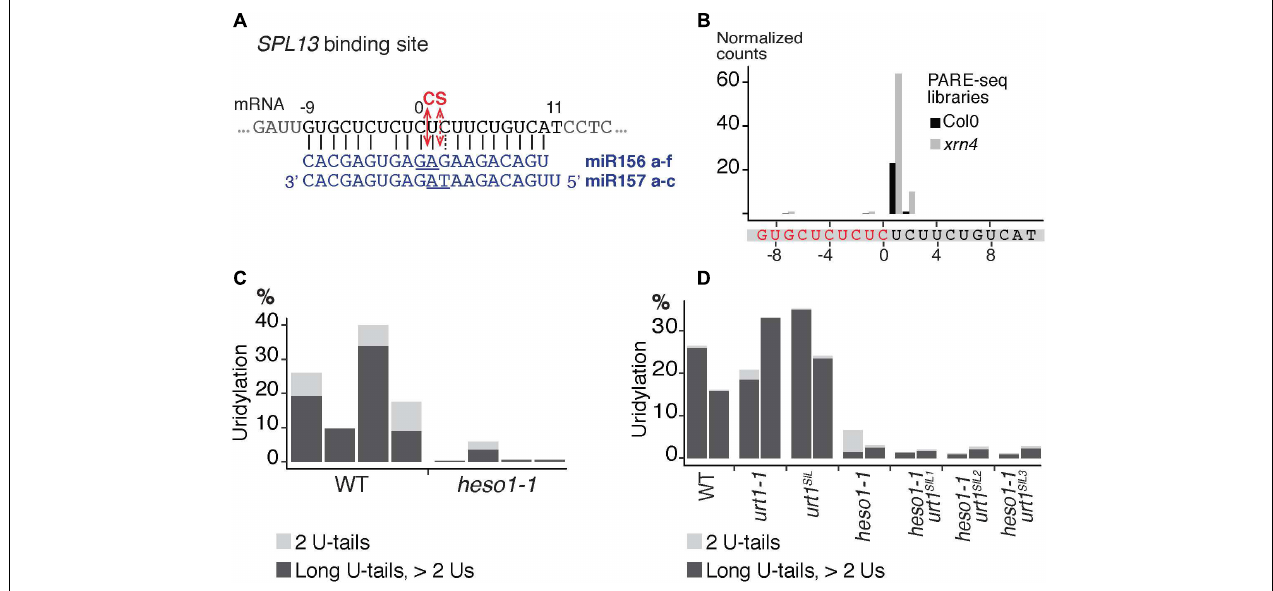
FIGURE 7 | Respective contributions of HESO1 and URT1 in the uridylation of SPL13 RISC 5 (cid:48) -cleavage fragments. (A) Schematic representation of the cleavage of SPL13 mRNA by AGO1 loaded with miR156 or miR157. The cleavage sites (CS) are predicted between the positions 0 and +1 or between position +1 and +2 for miR156 and miR157, respectively, and are defined by the 10th and 11th nucleotides (underlined) of the miRNAs. (B) 5 (cid:48) end mapping using PARE-seq data (German et al., 2008) of RISC 3 (cid:48) -cleavage fragments in WT and xrn4 . (C,D) Percentages of uridylated SPL13 RISC 5 (cid:48) -cleavage fragments in (C) four biological replicates for WT and heso1-1 or (D) two biological replicates for WT, urt1-1 , the urt1 SIL line, heso1-1 , and the three heso1-1 urt1 SIL lines (i.e., six heso1-1 urt1 SIL samples). Percentages of long ( > 2 Us) and 2 U-tails are indicated by dark gray and light gray,